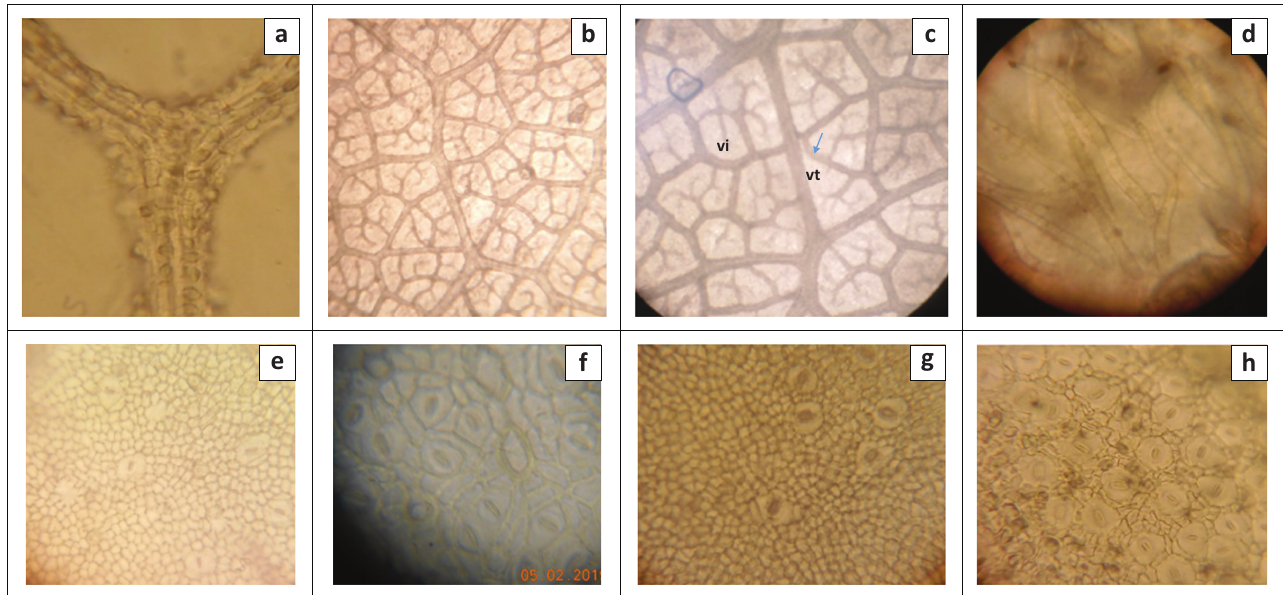
FIGURE 1: Epidermal leaf microscopy of Isoberlinia doka and Isoberlinia tomentosa . (a). Calcium oxalates crystals of I. tomentosa , mag ×400. (b) Vein islets (vi), vt: vein termination of I. tomentosa mag x100. (c). Vein islets (vi), vt: vein termination I. doka mag x100. (d). Trichomes of I. tomentosa mag x100. (e). Adaxial epidermis I. tomentosa of mag x400. (f). Abaxial epidermis I. tomentosa mag x400. (g). Stomata of I. doka at adaxial epidermis mag x400. (h). Stomata of I. doka at abaxial epidermis mag x400.